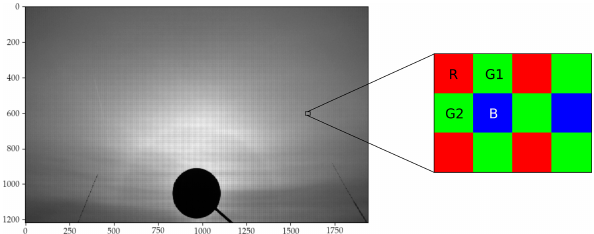
Figure 2. HaloCam RAW image as detected by the sensor. The im- age exhibits the superimposed mosaic pattern of the Bayer color filter array (CFA, Bayer, 1975), which is shown schematically on the right with the red (R), the two green (G1, G2), and the blue (B)